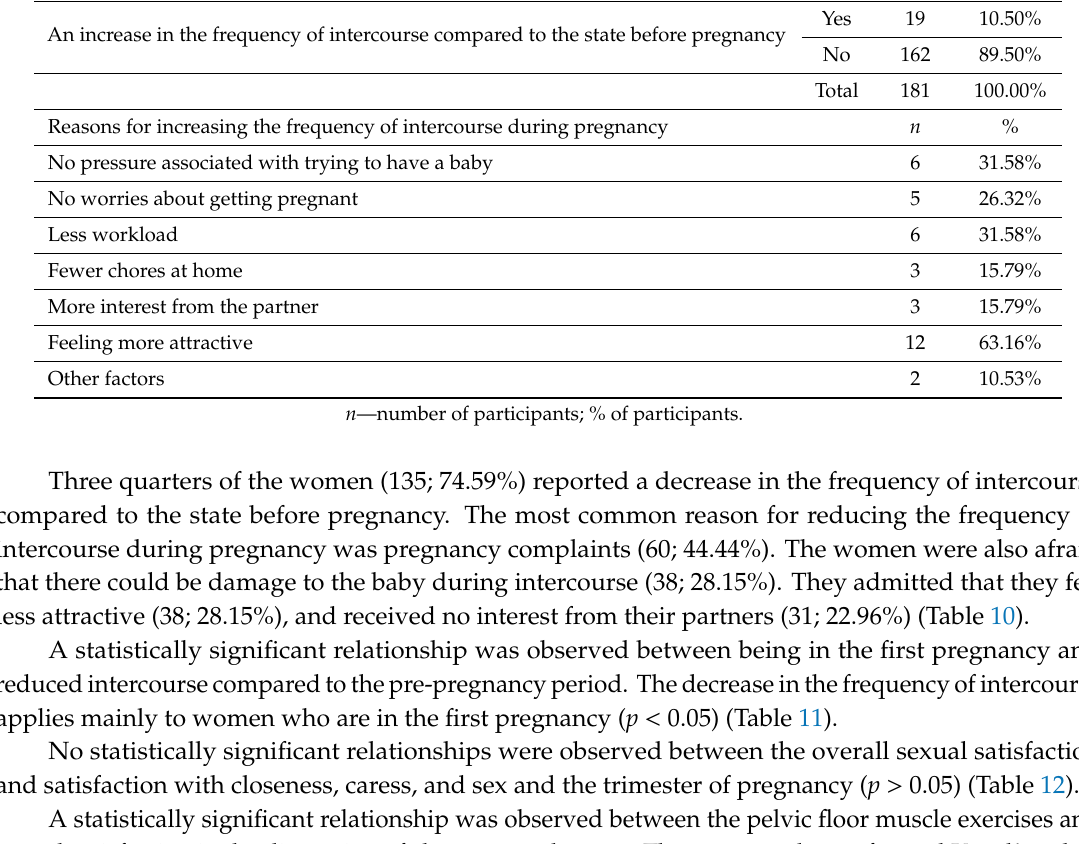
Table 9. An increase in the frequency of intercourse compared to the state before pregnancy. Variables n